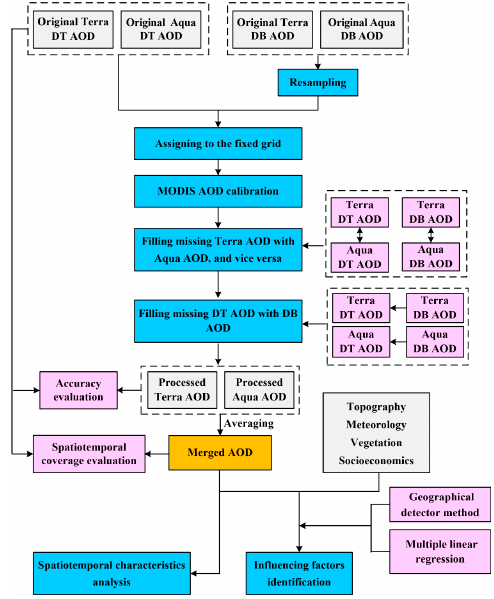
Figure 2. The framework of the study procedure.